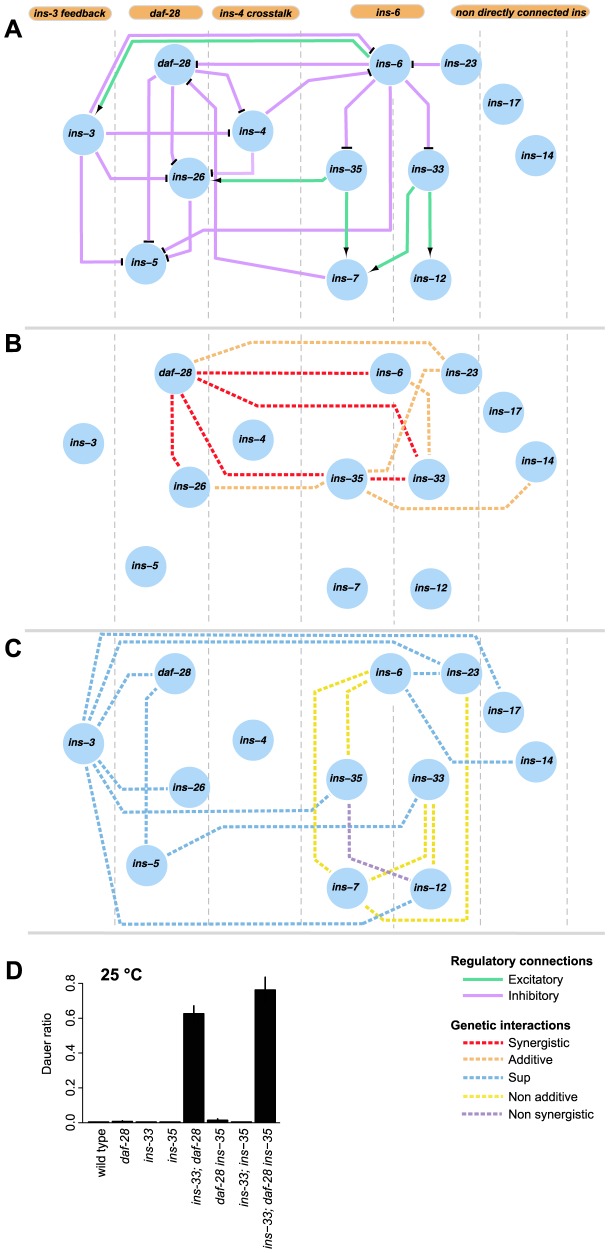
Information flow in the dauer entry sub-network.(A) shows the putative organizational structure of the dauer entry sub-network comprised of dauer entry-regulating ILPs compared to their genetic interactions (B, C). Genetic interactions classified as additive or synergistic (B); or non-additive, suppression or non-synergistic (C). (D) Shows the ratio of dauer formation of the triple mutant ins-33; daf-28 ins-35 compared to double or single mutant strains. ins-33; daf-28 and ins-33; daf-28 ins-35 mutants are significantly more likely to enter dauer than all other strains (p<0.001, Hypergeometric test).